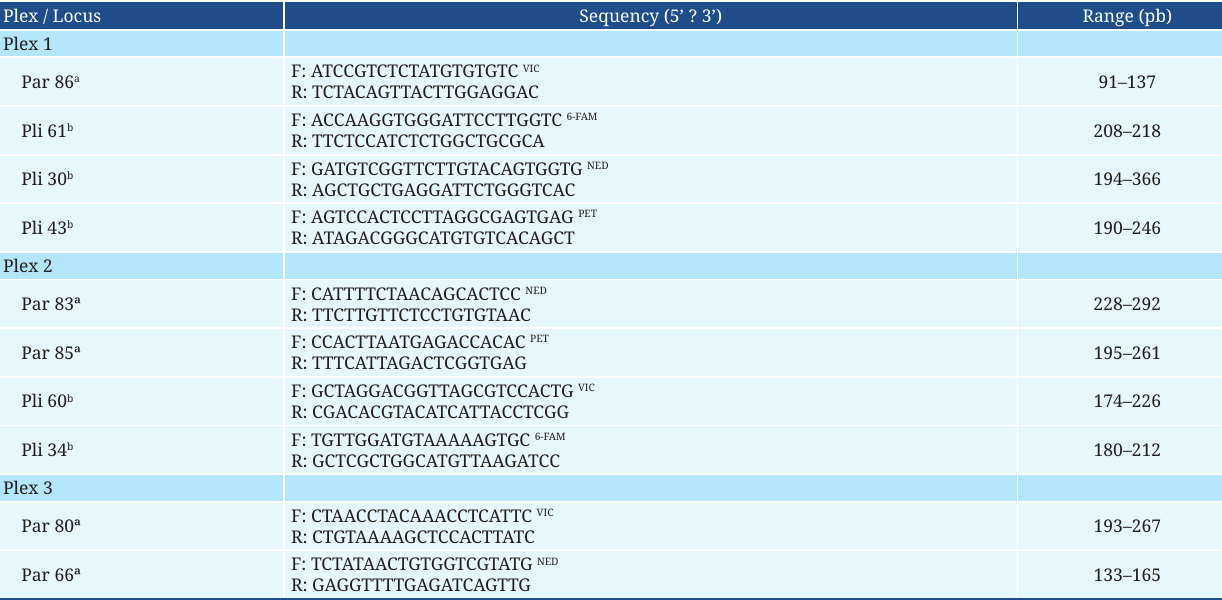
TABLE 1 | Microsatellite loci of Prochilodus lineatus (Pli) and P. argenteus (Par) used in the study and multiplexed in three distinct reactions (plex 1, plex 2, and plex 3). ªBarbosa et al ., 2008; b Yazbeck, Kalapotakis, 2007.